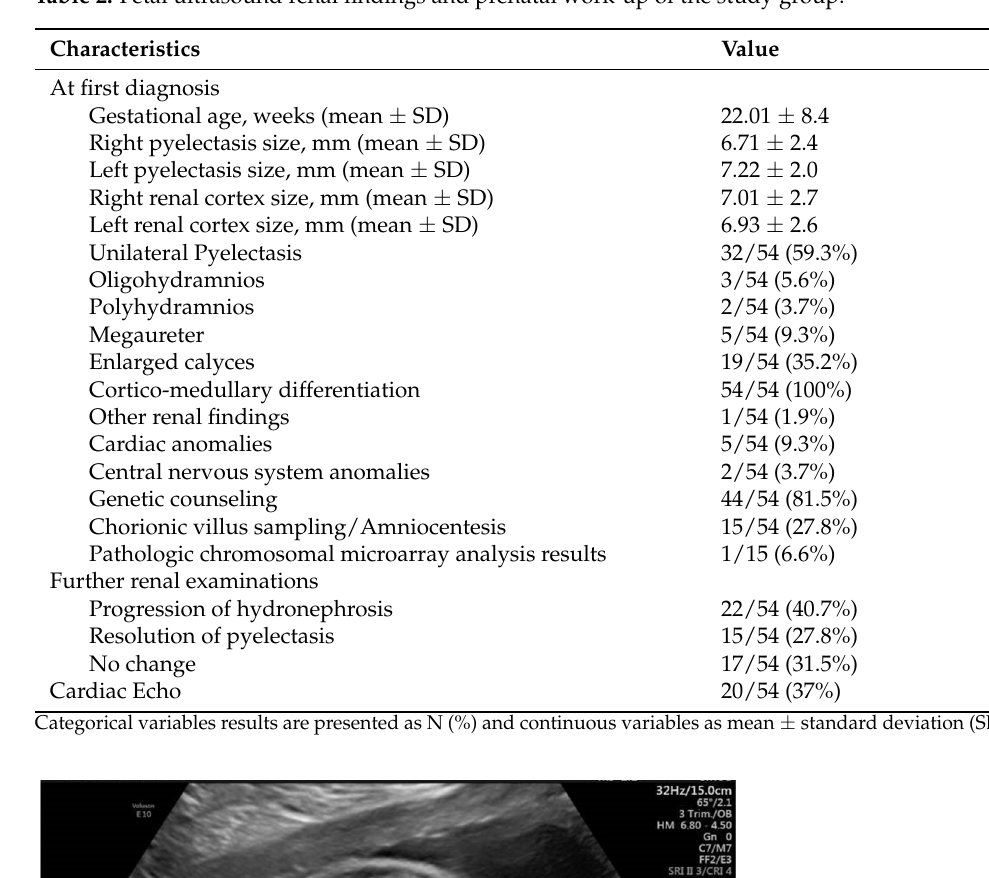
Table 2. Fetal ultrasound renal findings and prenatal work-up of the study group.